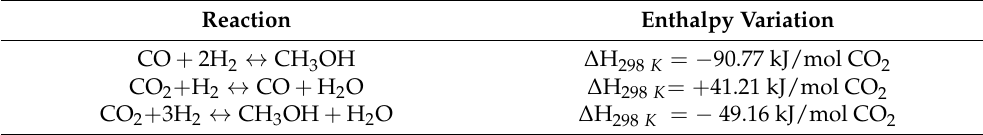
Table 2. Methanol synthesis reactions on the Cu/Zn/Al/Zr catalyst